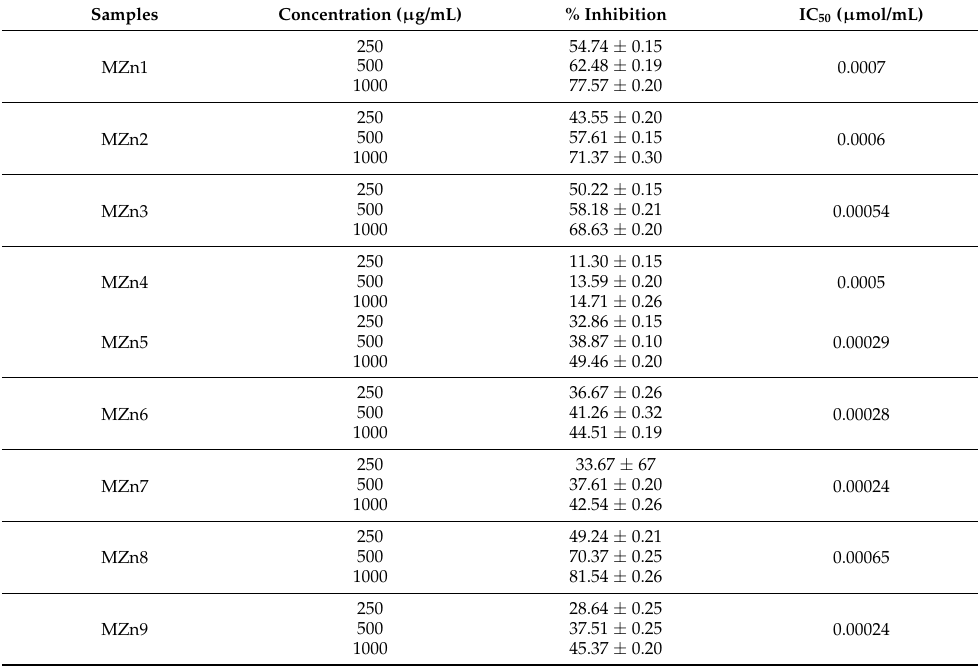
Table 6. α -Glucosidase activity of